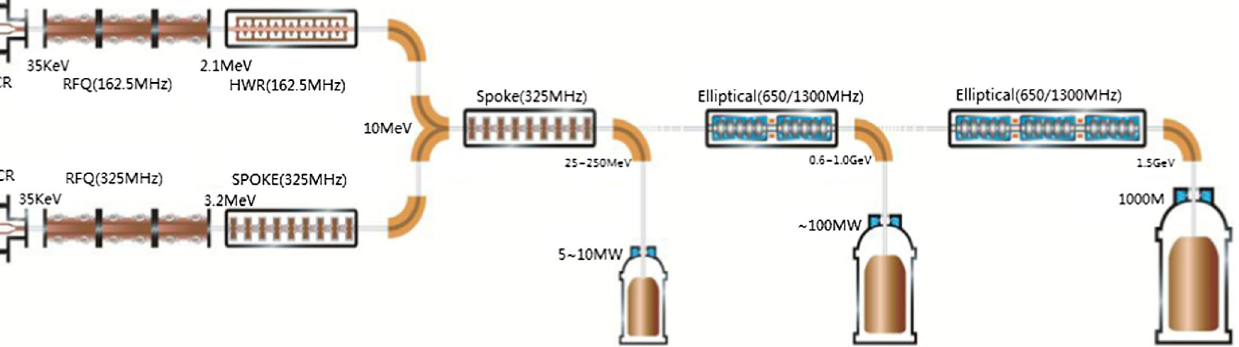
II.FIG. 1. Layout of the C-ADS.